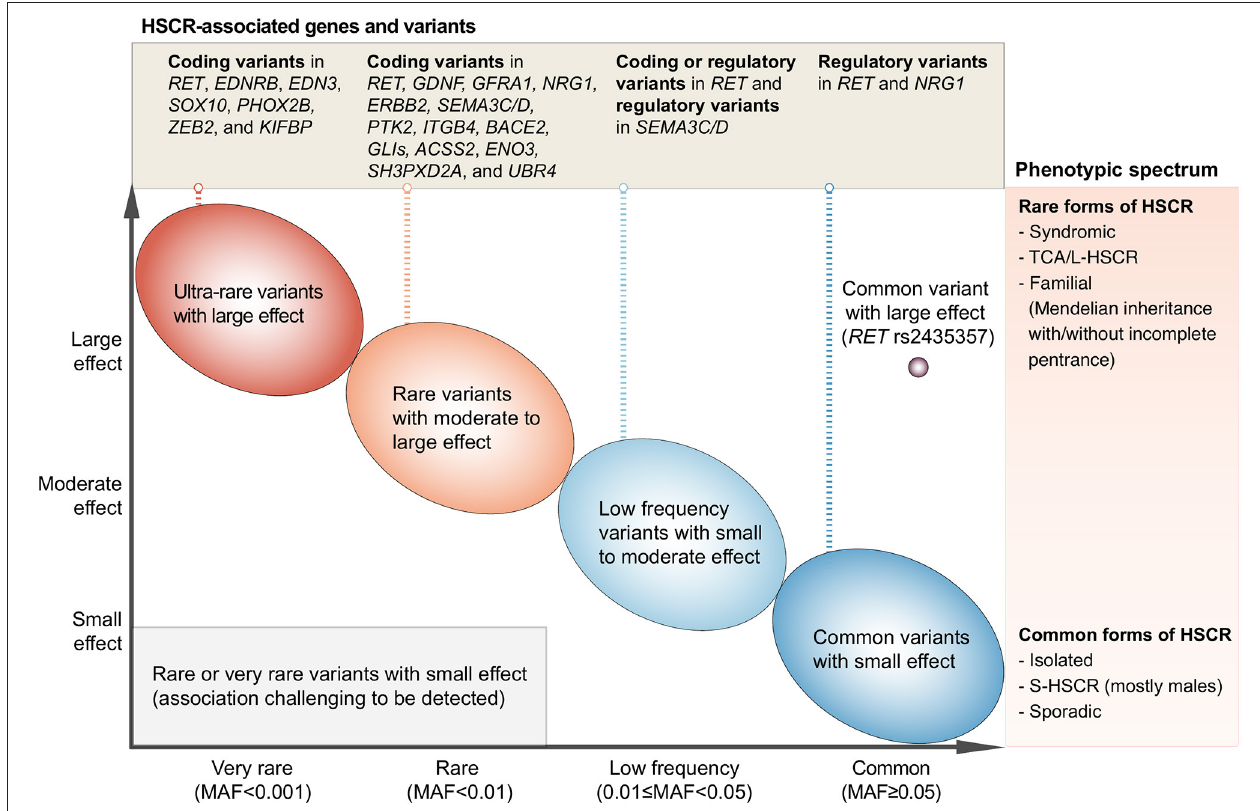
FIGURE 1 | Current understanding of the genetic architecture of HSCR. The x -axis denotes the minor allele frequency (MAF) of variants and the y -axis denotes the effect size. HSCR-associated genetic variants range from variants with extremely low MAF and very large effect size (upper-left side of the plot) to the common/low-frequency variants with small to large effect size (right side of the plot). These variants have been reported in the HSCR loci shown in the upper panel and can cause HSCR with a wide spectrum of severity as denoted in the right panel. On one end of the phenotypic spectrum lies the syndromic HSCR and TCA/L-HSCR, which are the rarer and severe form of HSCR whereas on the other end lies the commonest form of HSCR, i.e., sporadic S-HSCR.